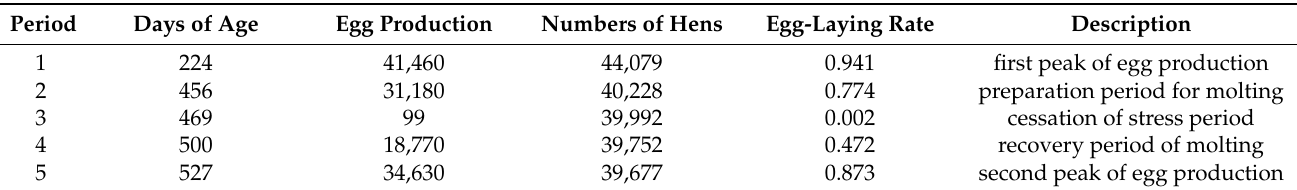
Figure 1. Feather appearance phenotypes in hens of five different growth periods during FM. Period 1 ( A ), Period 2 ( B ), Period 3 ( C ), Period 4 ( D ), Period 5 ( E ). Table 1. Description of chicken population information before and after molting in five different sampling